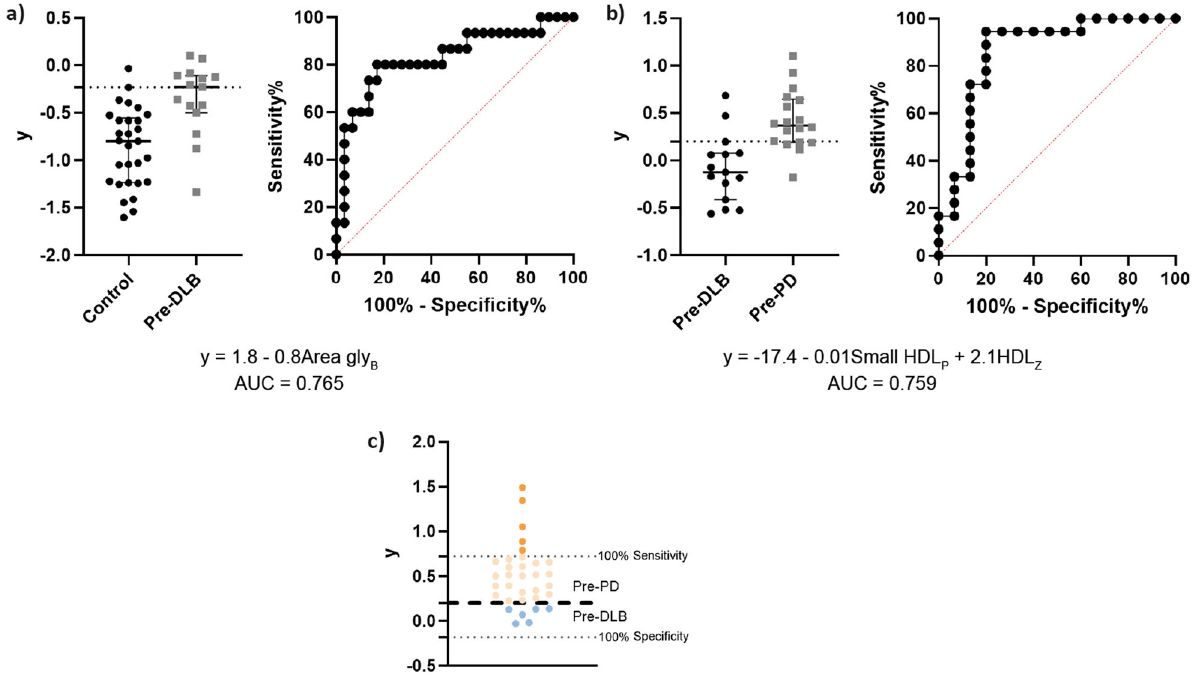
Fig. 3 Discriminatory models. Graphs showing the results of the equation (written underneath) that allows distinguishing between controls and pre-DLB patients ( a ), and pre-DLB and pre-PD patients ( b ), including the threshold with the highest likelihood ratio (gray dotted line), together with the pertinent ROC curve and area under the curve (AUC) values. The application of model ( b ) in iRBD-only samples ( c ) distinguishes between putative pre-DLB (blue dots) and pre-PD (orange dots, darker orange implies 100% sensitivity)